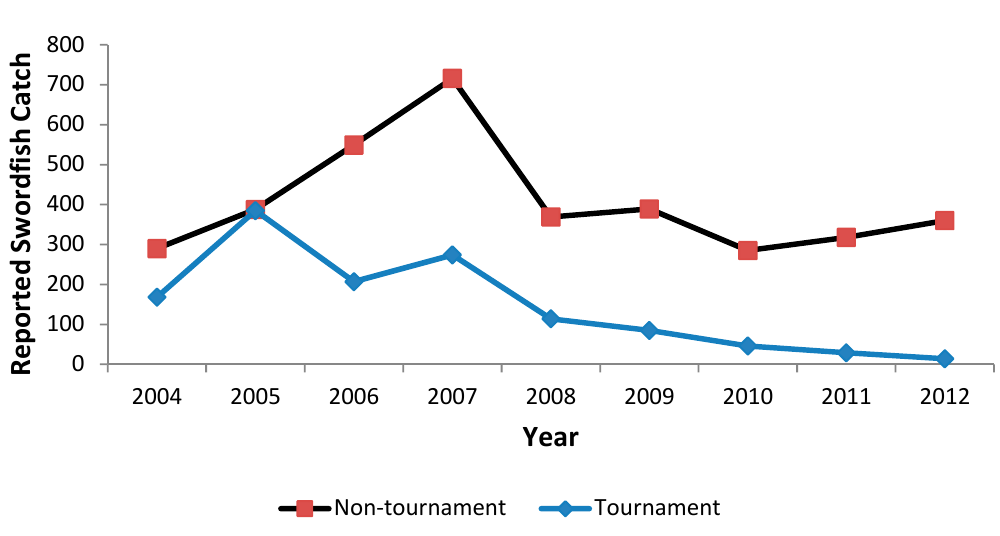
Figure 7. Reported recreational swordfish landing during 2004 through 2012 [21].